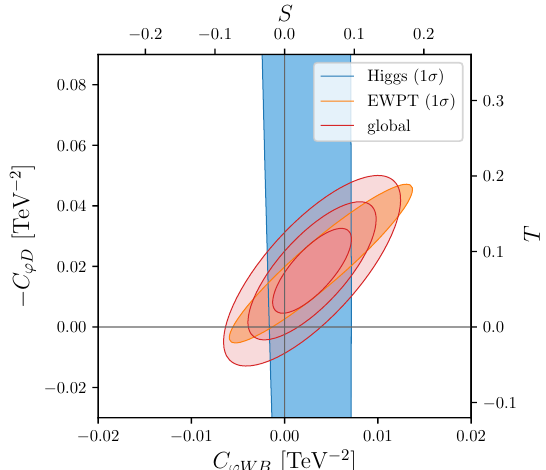
Figure 2 . S-T (cid:12)t using our combined Higgs and electroweak likelihood. We assume the only non- negligible Wilson coe(cid:14)cients of dimension-6 operators at the scale m Z are c ’D and c ’WB . This is equivalent to the usual (cid:12)t to the oblique S and T parameters via the map in eq. (5.1). We show the 1 (cid:27) preferred region separately for Higgs (blue) and electroweak (orange) data. The red contours mark the 1 (cid:27) , 2 (cid:27) , and 3 (cid:27) preferred regions using the combined